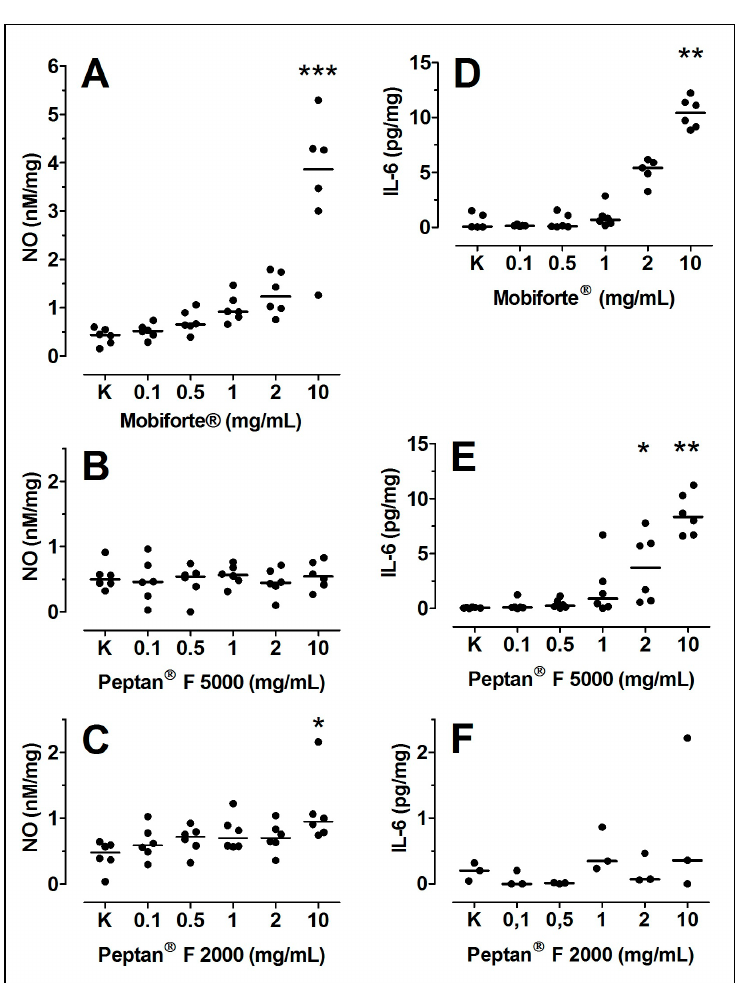
Figure 7. Concentration-dependent effects of CHs on NO and IL6. NO ( A – C ); and IL6 ( D – F ) were determined in the media of cultured articular cartilage explants treated with 0–10 mg/mL CHs. Data are shown as dot plots with their median ( n = 6). Significant differences between treated and untreated controls (100%) were defined with p-values as follows: * 0.01 < p ≤ 0.05, ** 0.001 < p ≤ 0.01, *** p < 0.001.